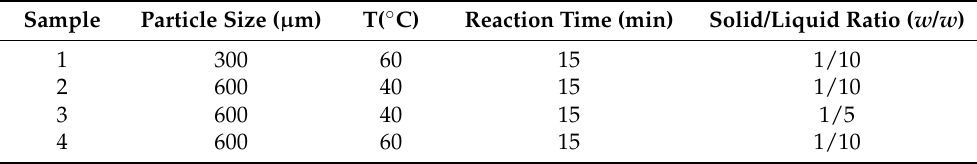
Table 1. List of four different bioplastic films obtained by different process and made for further in-depth studies. (1) From crude rapeseed cake; (2) from defatted cake; (3) from deproteinized cake; (4) from defatted and deproteinized rapeseed